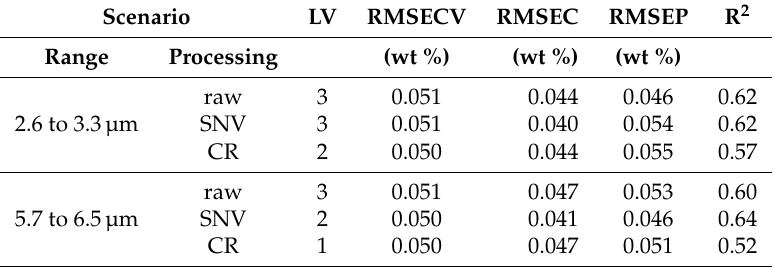
Table 2. Summary of the parameters and performance indicators of the best partial least